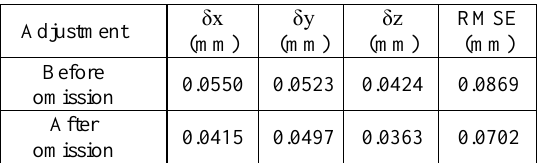
Table 7. The results of bundle adjustment of the plane nose before and after omission of images with low fuzzy values The result of Table 7 shows that the accuracy of bundle adjustment proves after omission of stations with low fuzzy values. Camera station error ellipsoids for plane nose before and after omission of improper images are shown in Figure 6 in the same scale of 1000 greater. As Figure 6 shows, after omission of improper images, rest of error ellipsoids growing smaller.